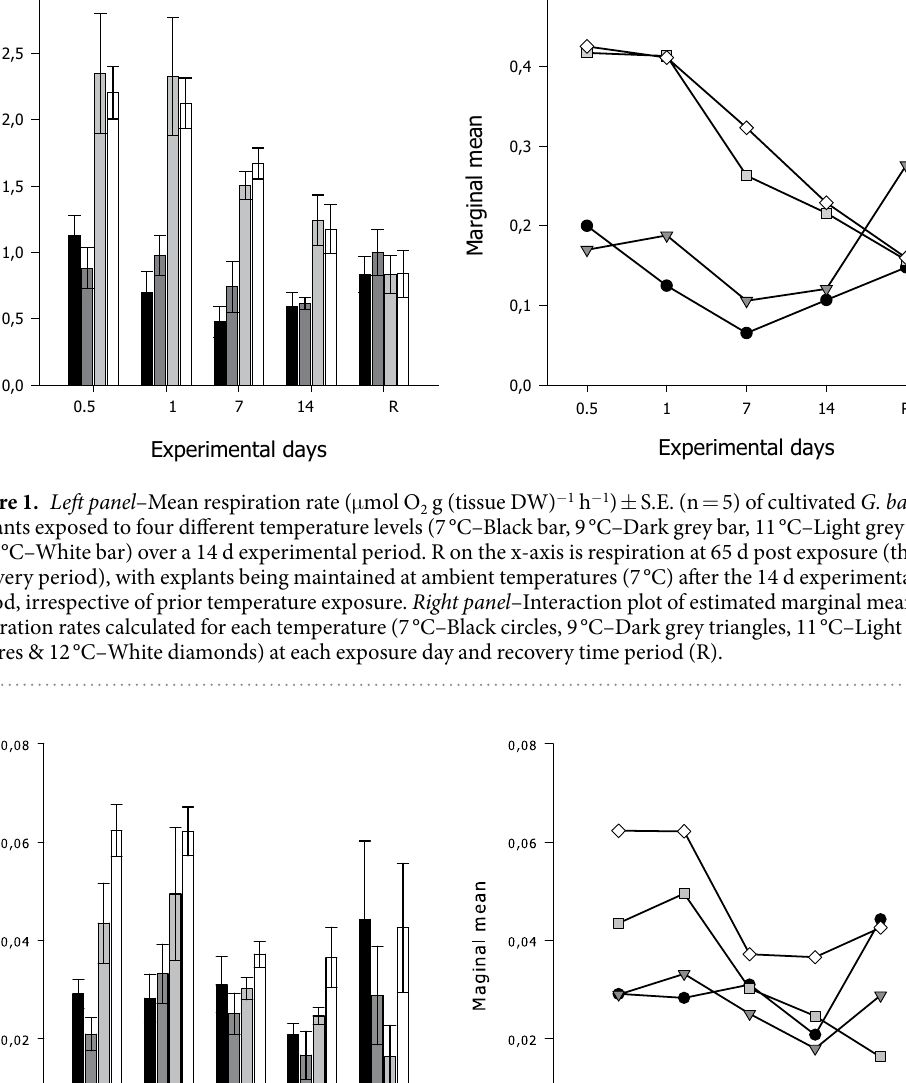
respiration rates returned to ambient levels after 65 d recovery, ranging between 0.83–1.00 μ mol O 2 g(tissue DW) − 1 h − 1 (Fig. 1). Nutrient utilisation. significantly affected by both temperature ( P = 0.014, Table 1) and the duration of exposure ( P = 0.002, Table 1) over the experimental period. Trends of increased marginal means for G. barretti explants exposed to water temperatures 4 and 5 °C above ambient temperatures (11 and 12 °C, respectively) were consistently higher than G. barretti explants exposed to ambient temperature (7 °C) for the first 24 h (Fig. 2). The highest